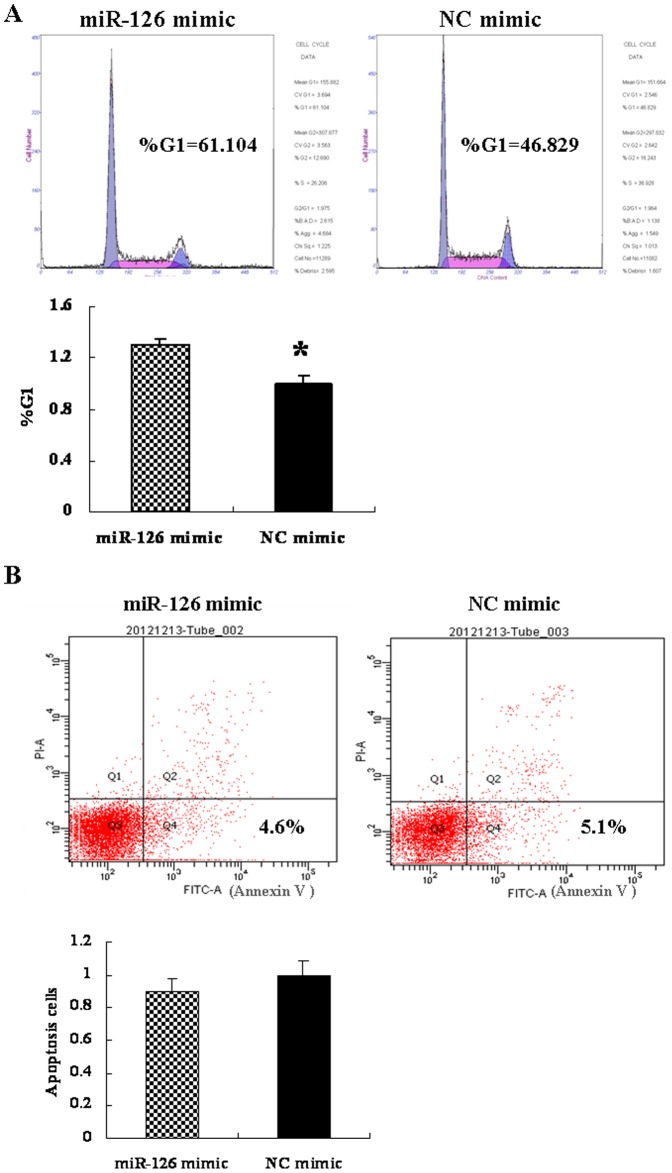
MicroRNA 126 (miR-126) mimic induces G0/G1 phase arrest, but had no effect on cell apoptosis.(A) MiR-126 mimic and NC mimic transfected cells were stained with propidium iodide (PI) and the DNA content was analyzed by flow cytometry. The number of cells in each phase was calculated using ModFit software. The results shown in the bottom graph were representative of three independent experiments (*P<0.05). (B) HT-29 cells were transfected with 50 nM miR-126 mimic or negative control mimic for 48 h. The percentage of apoptotic cells (Annexin V positive) relative to the total measured cell population is shown in the bottom right quadrant of the upper panel. The results were expressed as fold change relative to the corresponding NC mimic (bottom graph). (P>0.05, compared to that of NC mimic). Data are presented as mean ± SEM of three independent experiments.